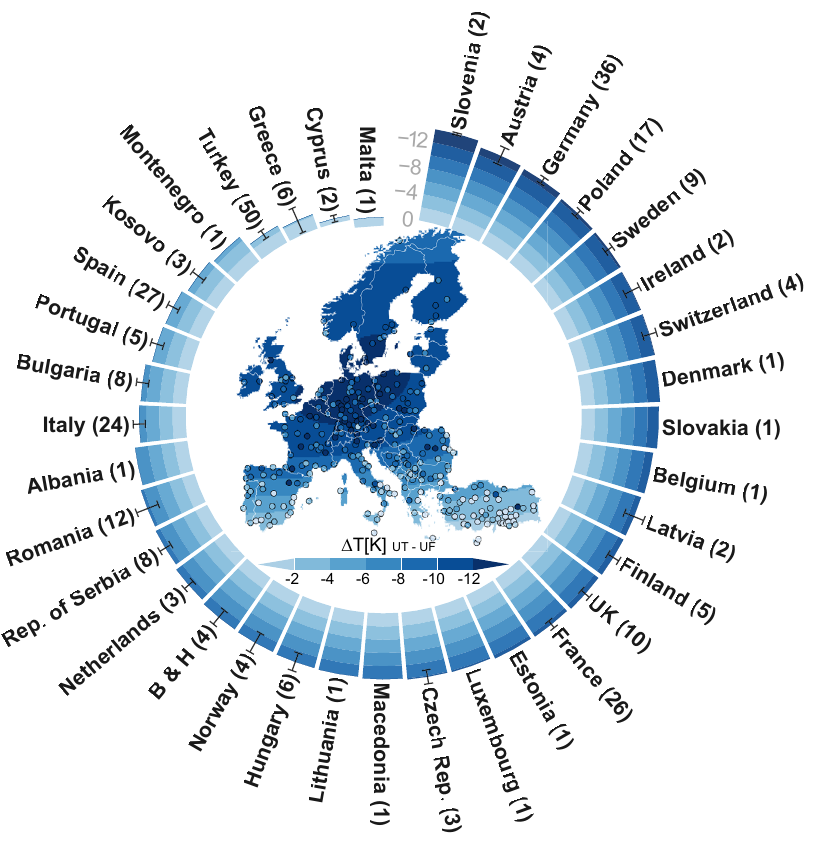
Fig. 1 Regional variation in temperature differences ( Δ T) during hot extremes between areas covered 100% by urban trees (UT) and areas covered 100% by continuous urban fabric (UF). The map shows smoothed spatial trends of the temperature differences, and each dot represents the temperature difference in a speci fi c city. Mean temperature differences for each country are indicated by stacked bars, and standard errors of the mean are also shown. The number of cities that could be used to calculate mean values in each country are indicated in brackets after the country name. B & H stands for the country Bosnia and